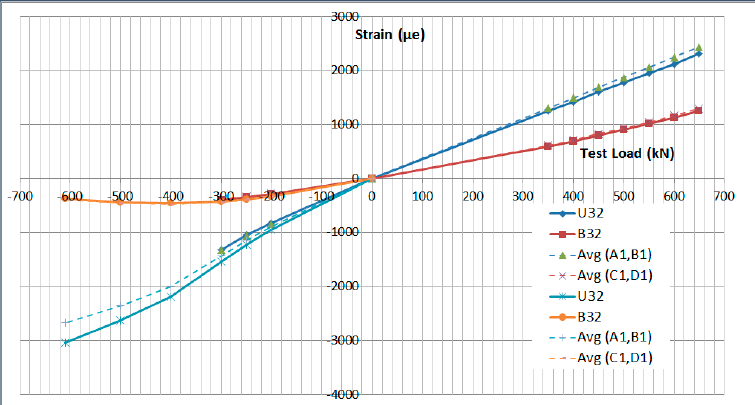
Figure 19. Failure Load Test Data Comparison.